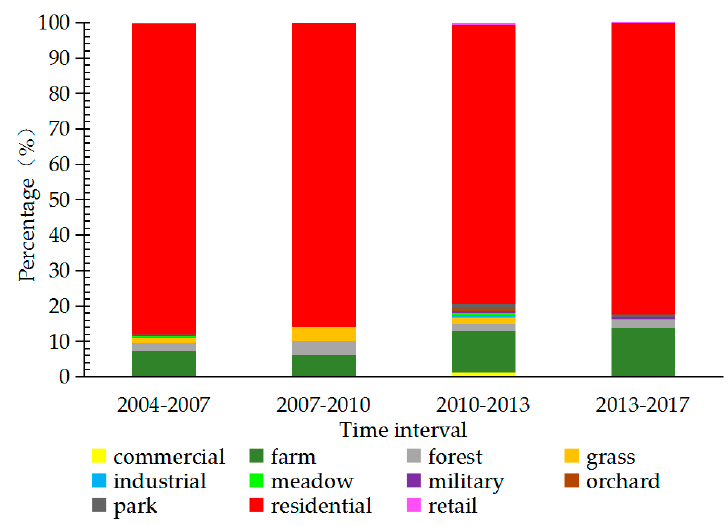
Figure 10. Statistics of urban expansion in Siem Reap from 2004 to 2017.